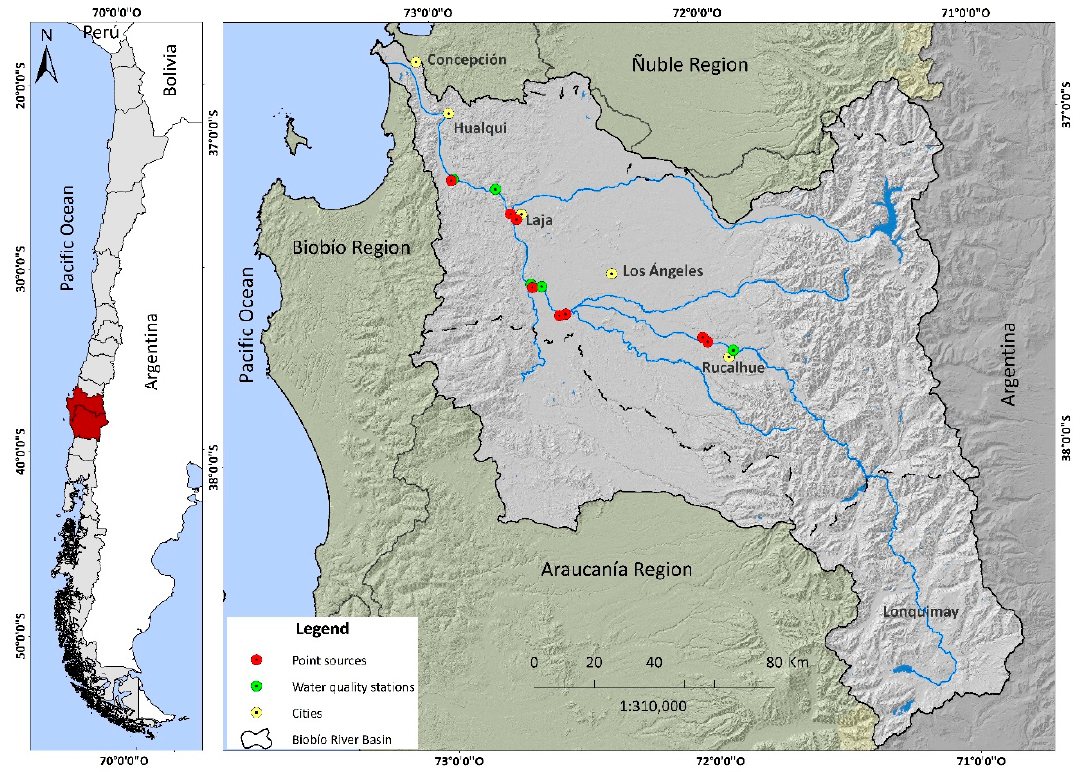
Figure 1. Location of the Biobío river basin.